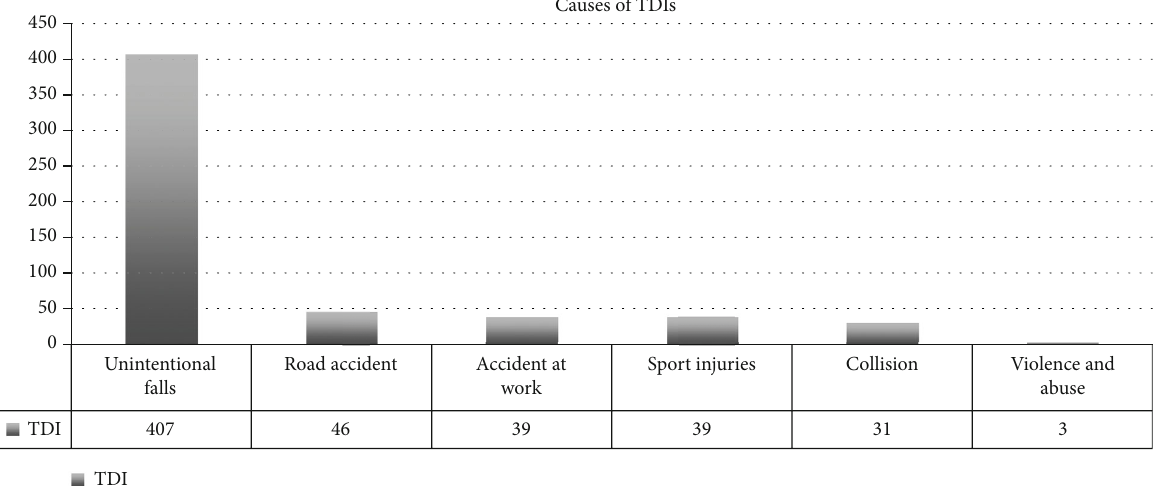
Figure 11: TDI frequency based on the cause of